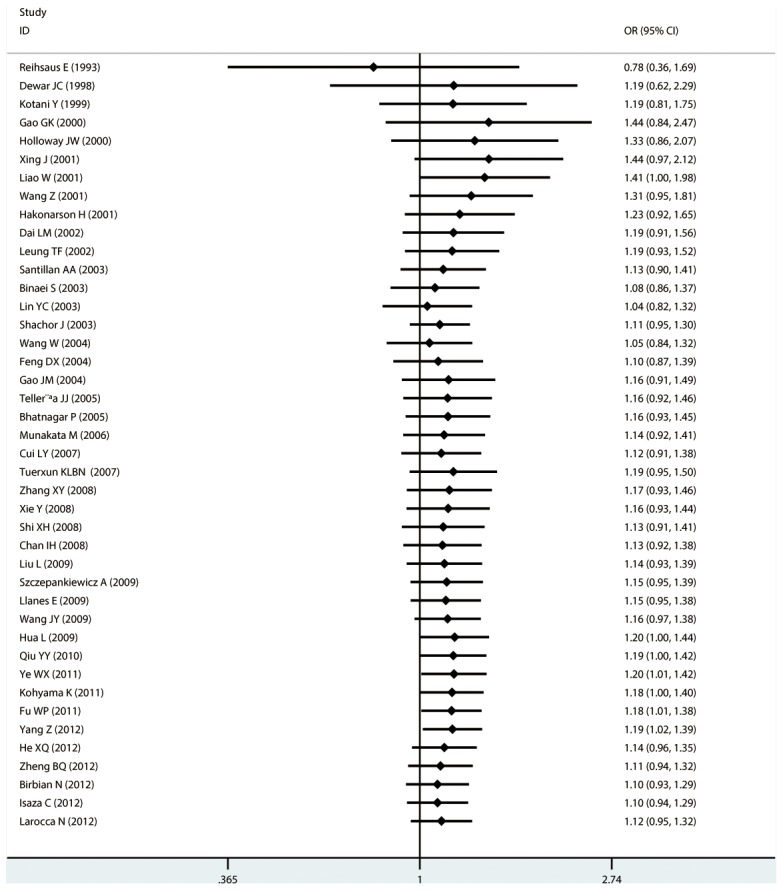
Forest plots of cumulative meta-analysis of Arg16Gly (rs1042713) in association with asthma by published year under recessive model comparison.